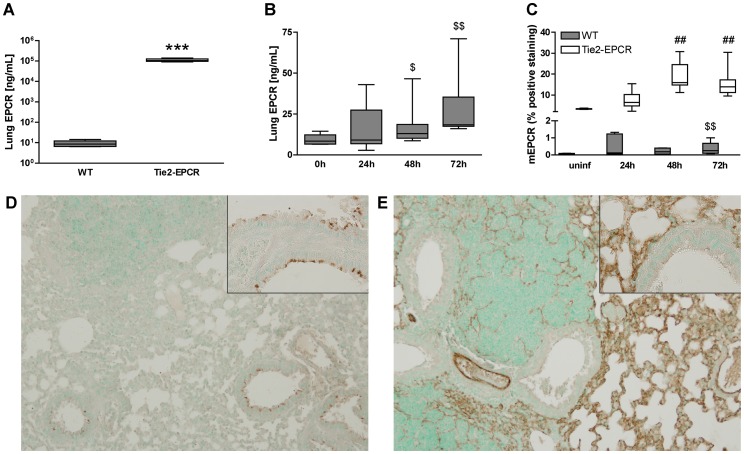
EPCR measurements in lungs of uninfected mice and mice infected with B. pseudomallei.Uninfected EPCR-overexpressing mice (Tie2-EPCR mice) have more than 10.000-fold higher levels of lung EPCR as measured by ELISA (A). Mice, inoculated with 300 CFU of B. pseudomallei and sacrificed after 24, 48 and 72 hours, had increased levels of EPCR in their lungs when compared to uninfected WT mice (B). Immunohistochemical staining of uninfected and B. pseudomallei-infected lung tissue showed increased EPCR-positive staining after 72 hours of infection in WT mice compared to uninfected controls and after 48 and 72 hours of infection in Tie2-EPCR mice when compared to uninfected Tie2-EPCR mice (C). Representative EPCR-staining of lung tissue of WT (D) and Tie2-EPCR (E) mice, 48 hours after infection (magnification 100×). Interestingly, at this time point WT mice showed EPCR-positive staining of bronchial epithelial cells (inset Figure D), whereas Tie2-EPCR mice (inset Figure E) did not (magnification 400×). Data are expressed as box-and-whisker plots showing the smallest observation, lower quartile, median, upper quartile and largest observation. Grey boxes represent WT mice, white boxes represent Tie2-EPCR mice (n = 8–9 mice per group for each time point). ***P<0.001 for WT versus Tie2-EPCR mice; $
P<0.05 and $$
P<0.01 for infected versus uninfected WT mice; ##
P<0.01 for infected versus uninfected Tie2-EPCR mice (Mann-Whitney U test).